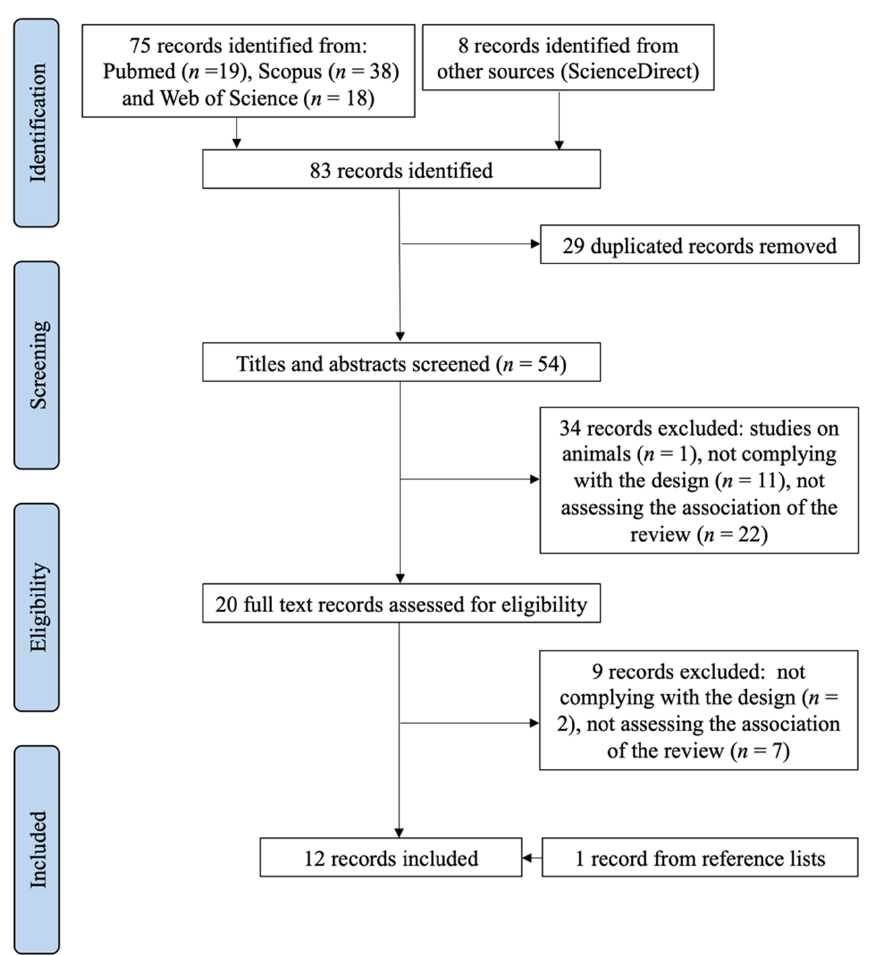
Figure 1. Flow diagram (PRISMA). Systematic selection of studies for review.